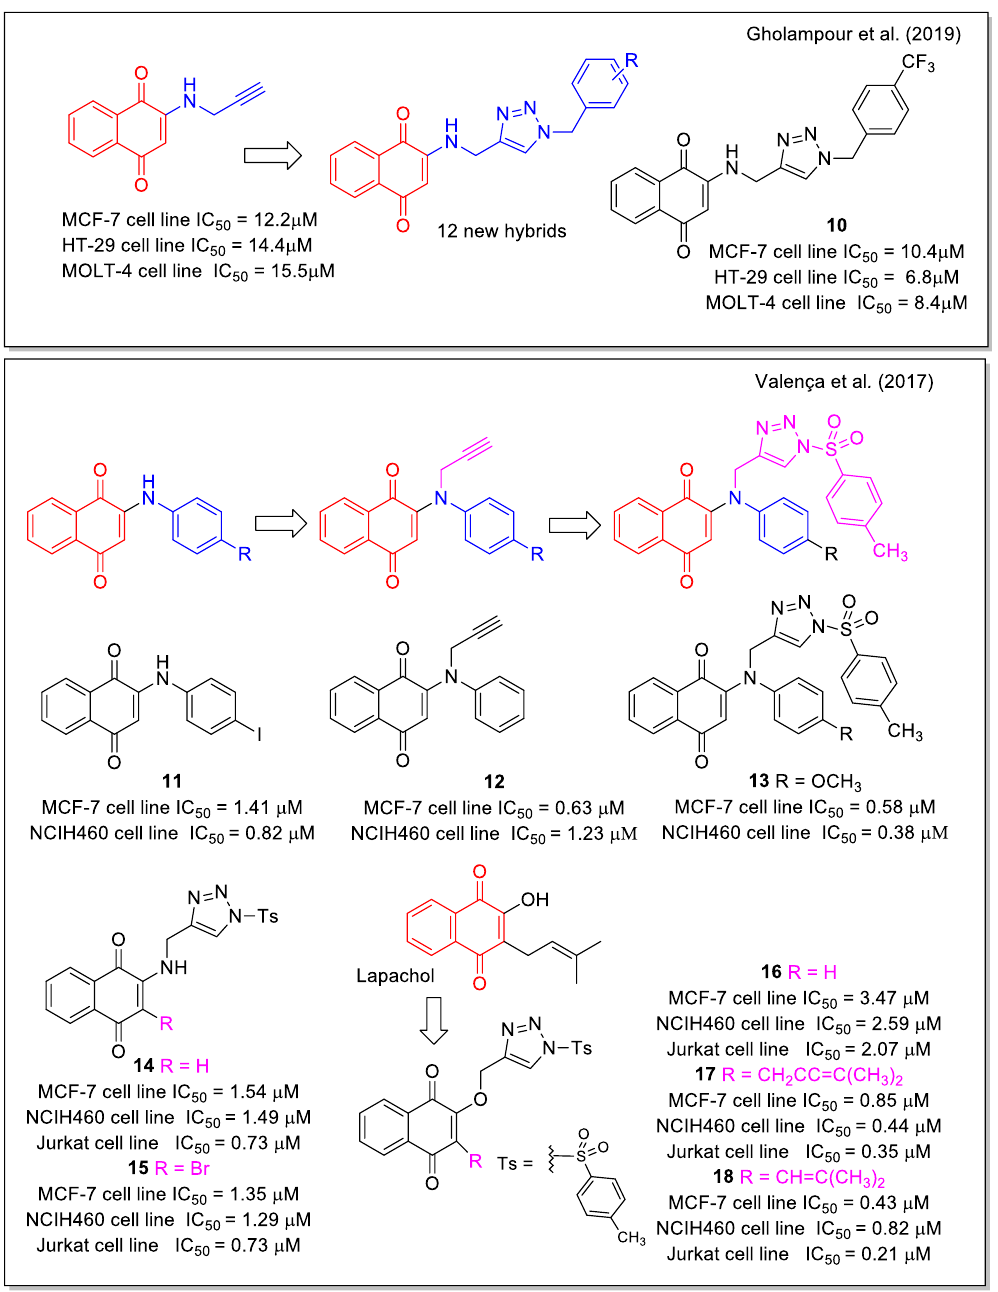
Figure 6. 1,4-Naphthoquinone hybrids with 1,2,3-triazole as reported by Gholapour et al. [33] and with N -sulfonyl 1,2,3,-triazole by Valença et. al. [34].